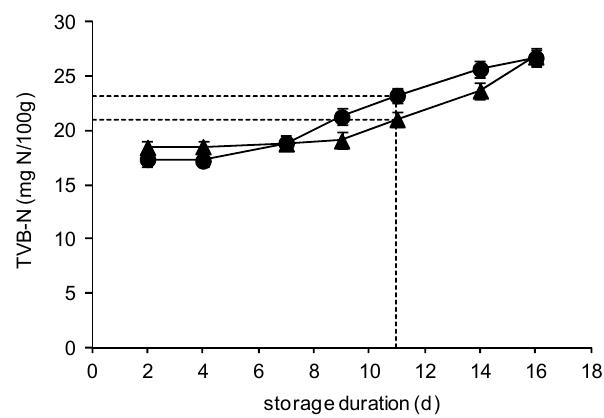
Figure 3. TVB-N changes of sea bass fillets ( ▲ ) and salmon slices ( ● ) stored under MAP at 2 °C. Each data point and the error bars show the mean ± standard deviation (mg N / 100 g) of 4 replicates. The cross-section of the dashed lines represents the point of sensory rejection (11 days).